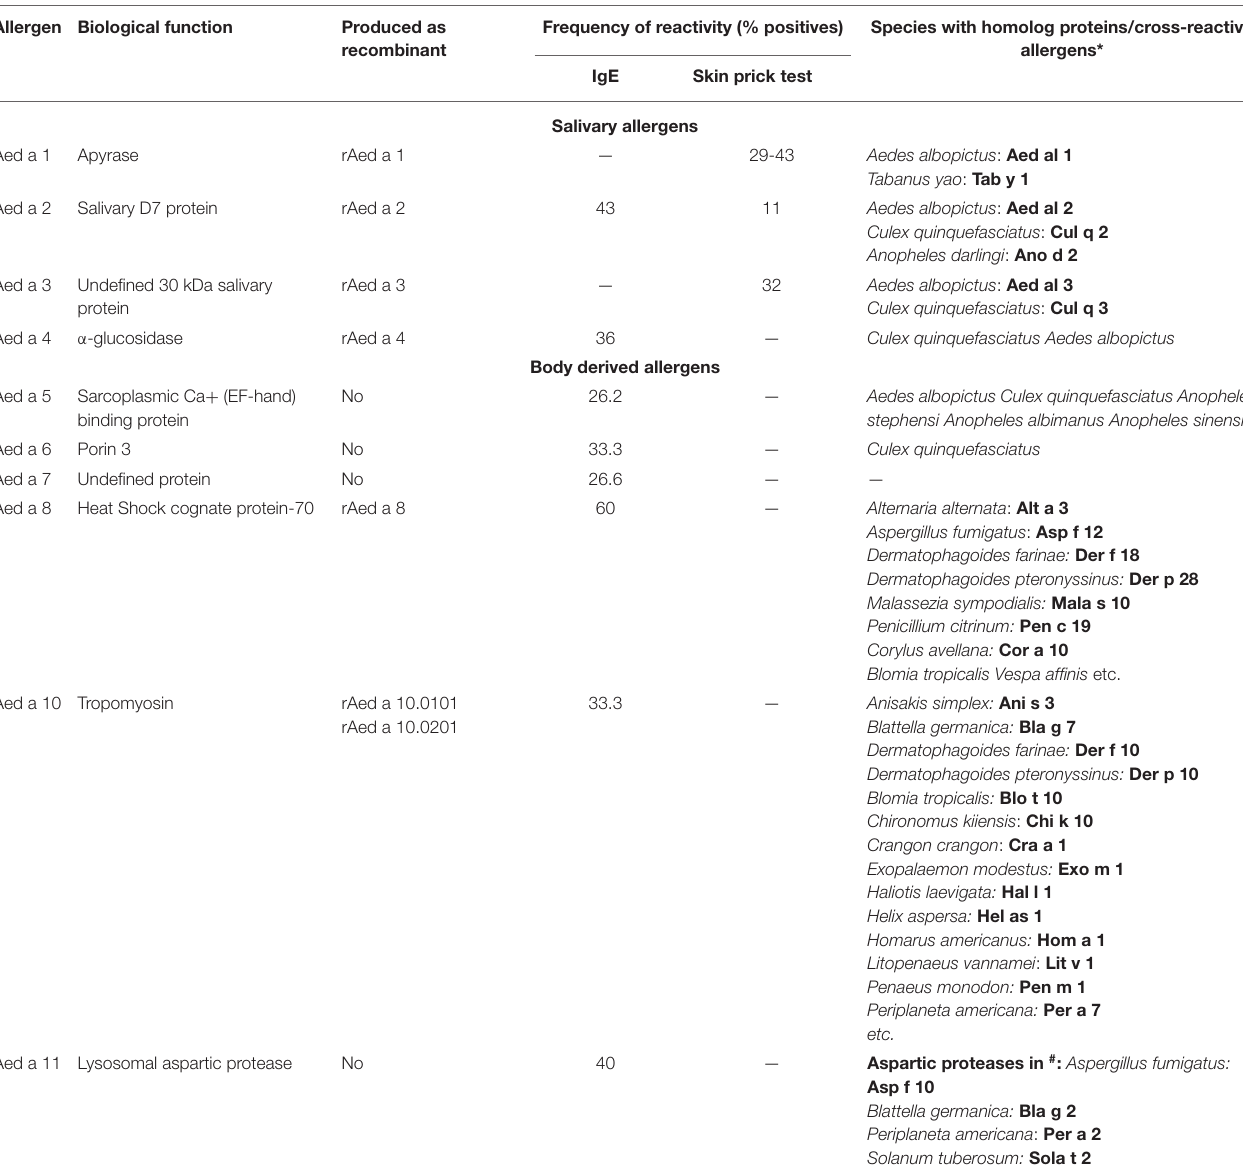
TABLE 2 | Reported mosquito